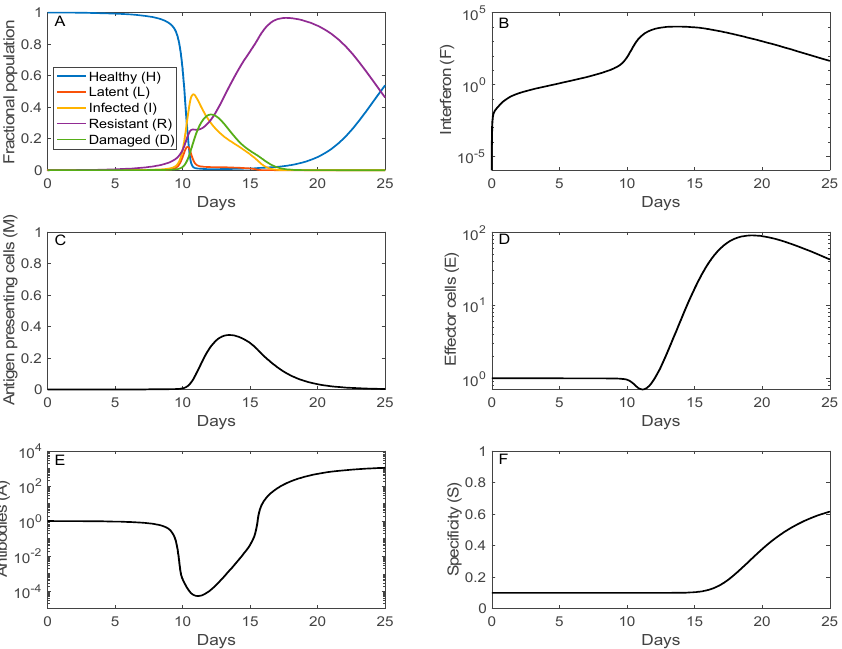
Figure 3. Time-courses of key immune system components as a function of days after initial viral exposure. Panel ( A ), fraction of the five classes of respiratory epithelial cells (healthy, latent, infected, resistant, and damaged). Initially, all cells are susceptible and healthy. A substantial fraction of the cells become infected by day 10. Afterwards, interferon renders most of the cells resistant. As the infection subsides, the cells gradually lose their resistance and become susceptible and healthy. Panels ( B – E ), population of interferon, antigen presenting cells, effector cells, and antibodies. Panel ( F ), specificity of antibodies, which increases monotonically over time.